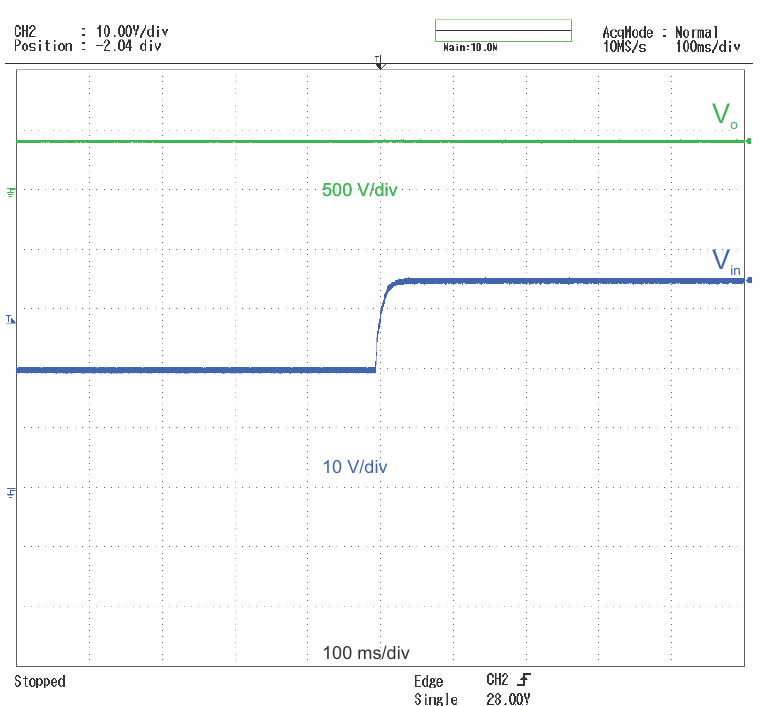
Figure 9. Dynamic response of the input voltage control for a step change from 20V to 35V.